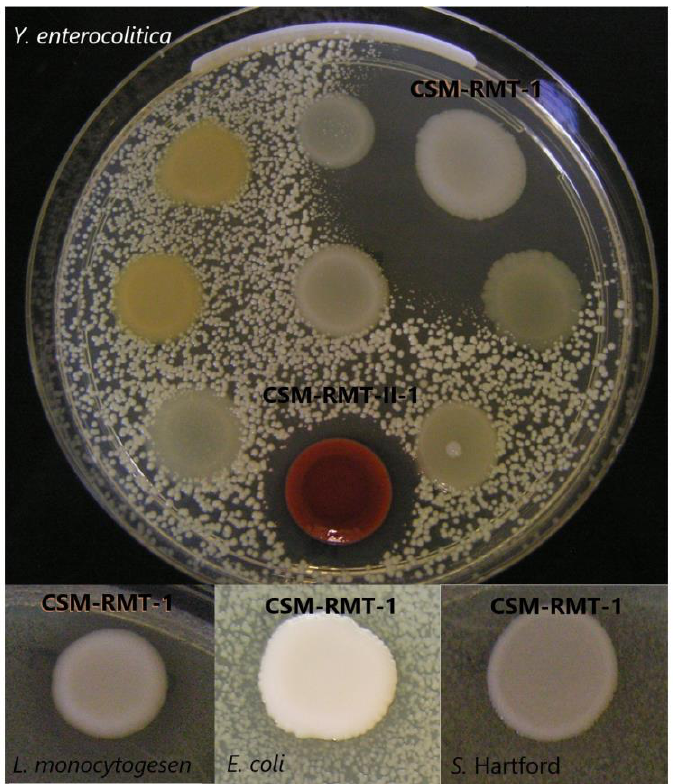
Figure 1. Effect of S. marcescens CSM-RMT-1 and CSM-RMT-II-1 strains on growth of Y. enterocolitica, L. monocytogenes and E. coli after 6 days of incubation at 30 °C detected with the agar spot method. In the case of Salmonella Hartford the zone was detected at 10 °C on day 3. Table 3. Inhibitory effect of Serratia marcescens CSM-RMT-1 at different incubation temperatures on growth of the pathogenic